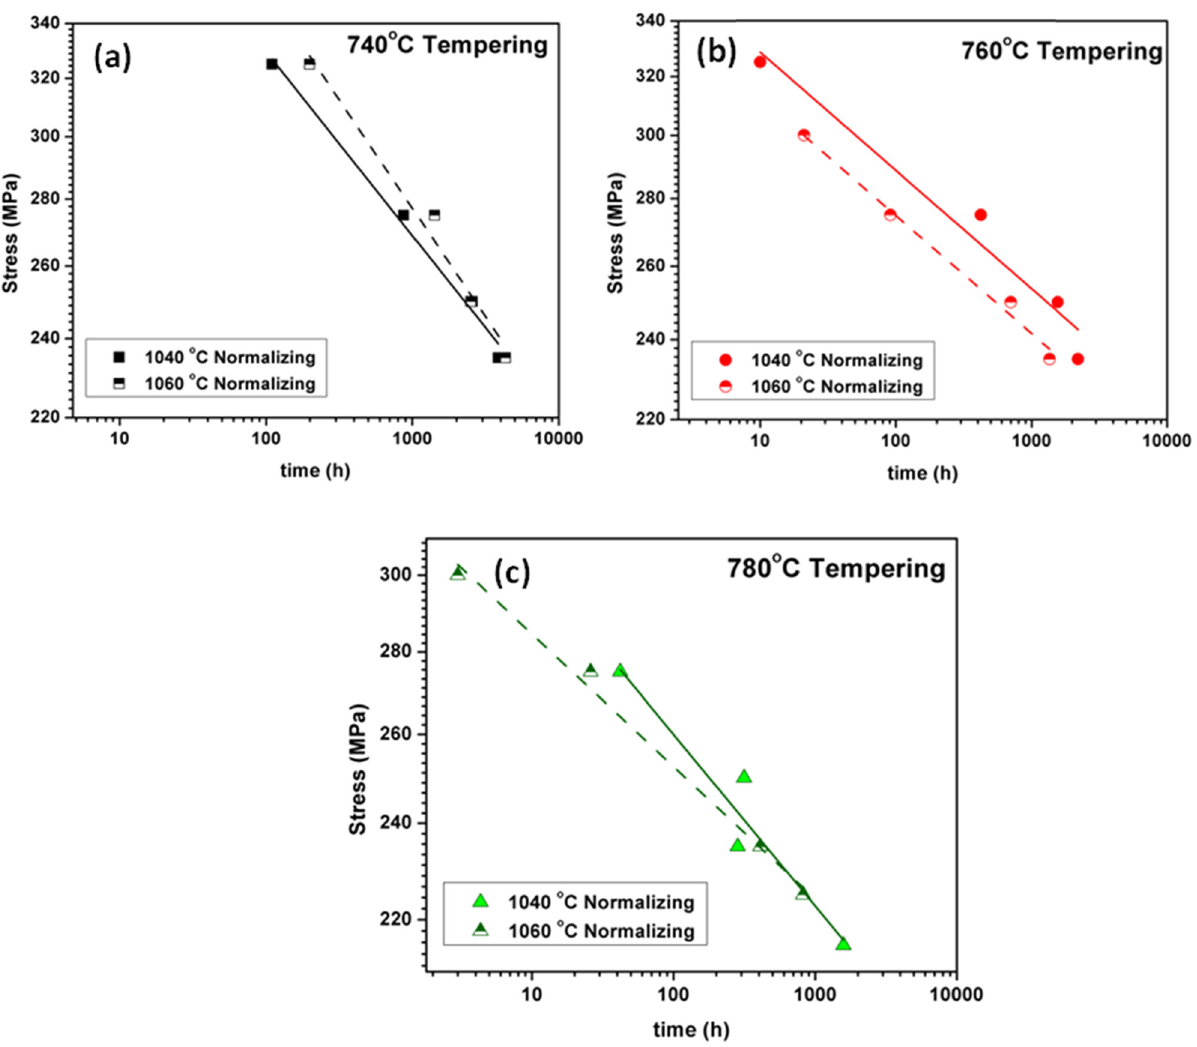
Figure 5: Summary of the stress rupture data revealing the effect of normalizing temperature for creep tests at 600°C, for tempering temperatures of ( a ) 740°C ( b ) 760°C ( c ) 780°C.